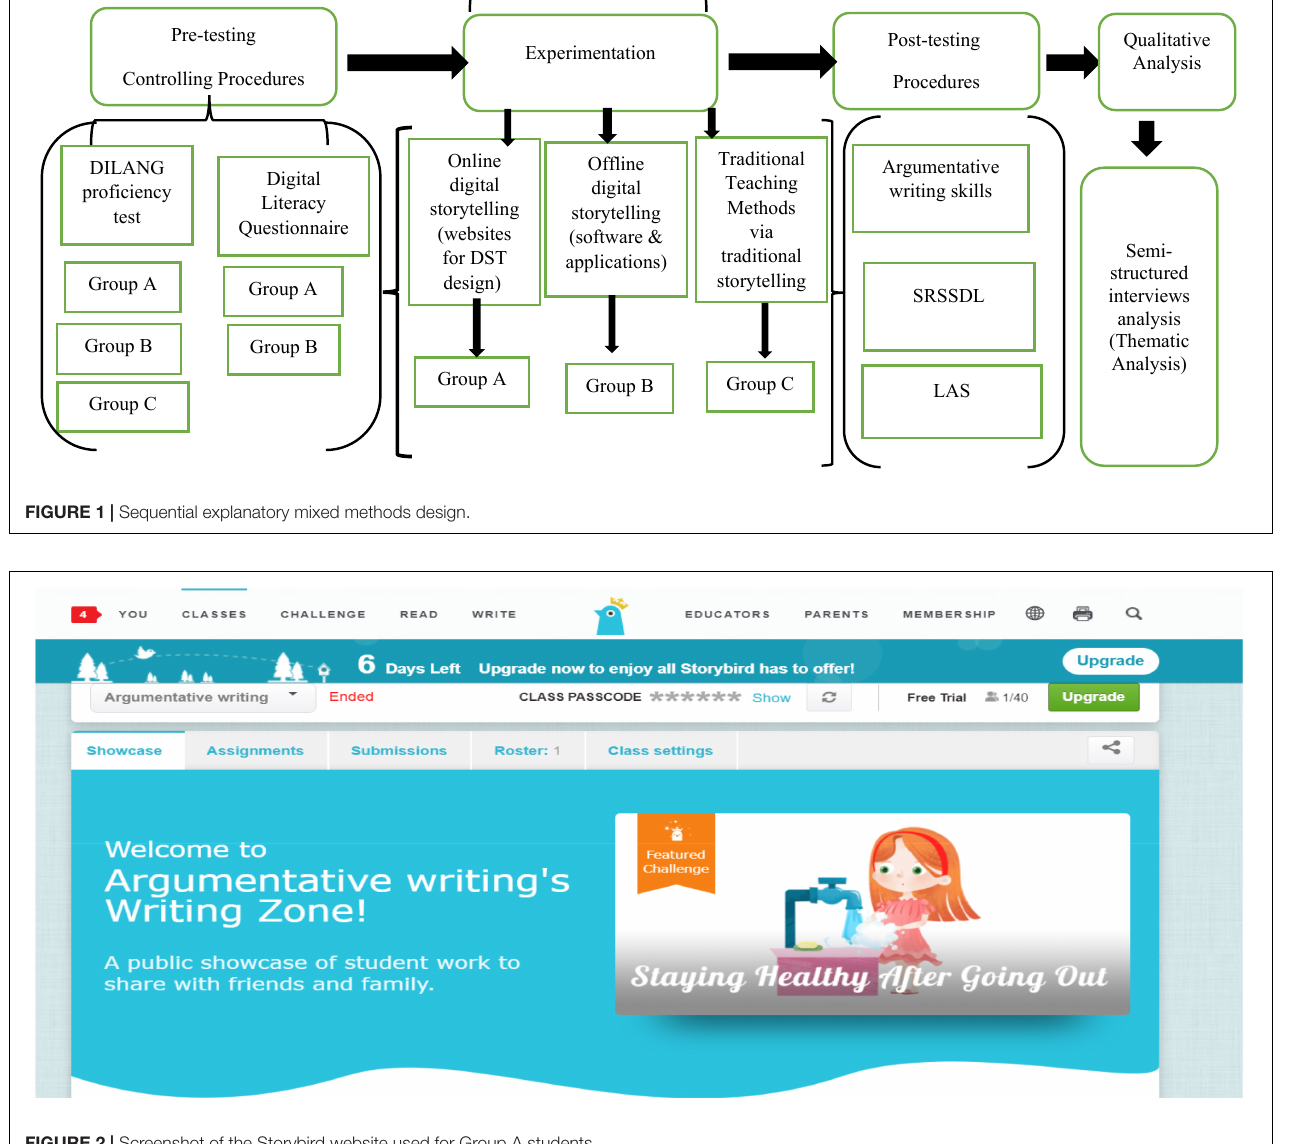
methodology to collect data and conduct various